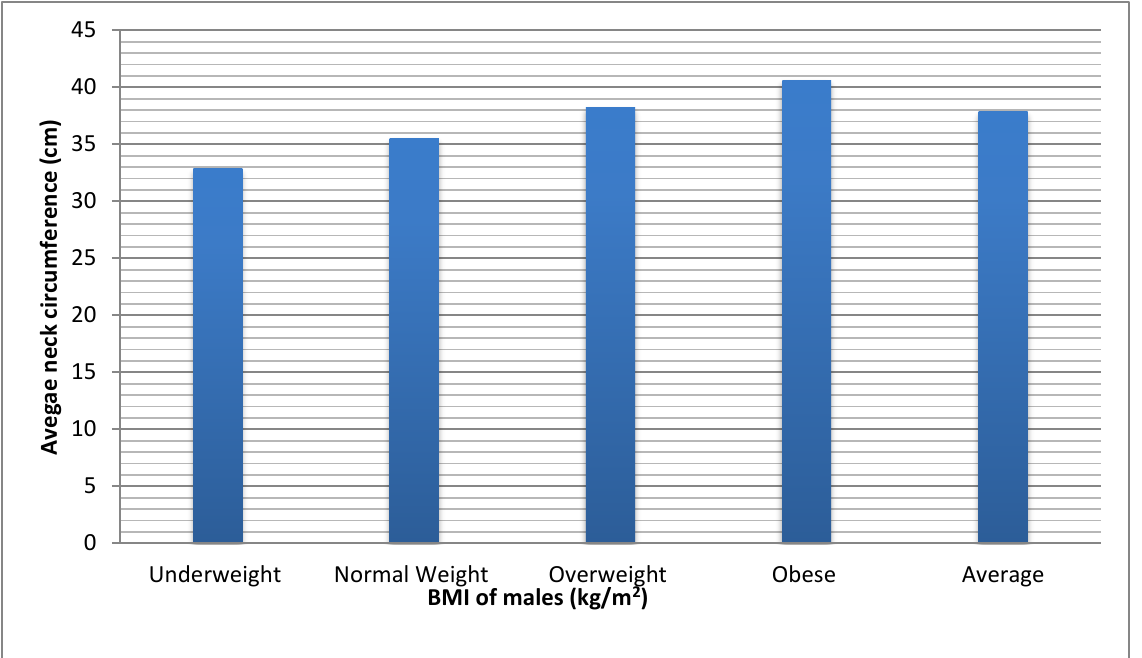
Underweight Normal Weight Overweight Obese